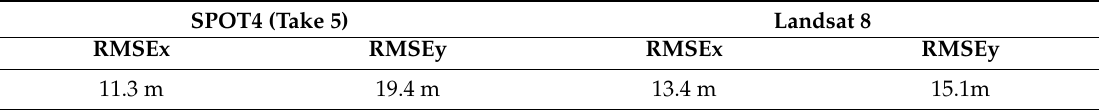
Table 5. Geometric consistency of the RapidEye data set with SPOT4 (Take 5) and Landsat 8